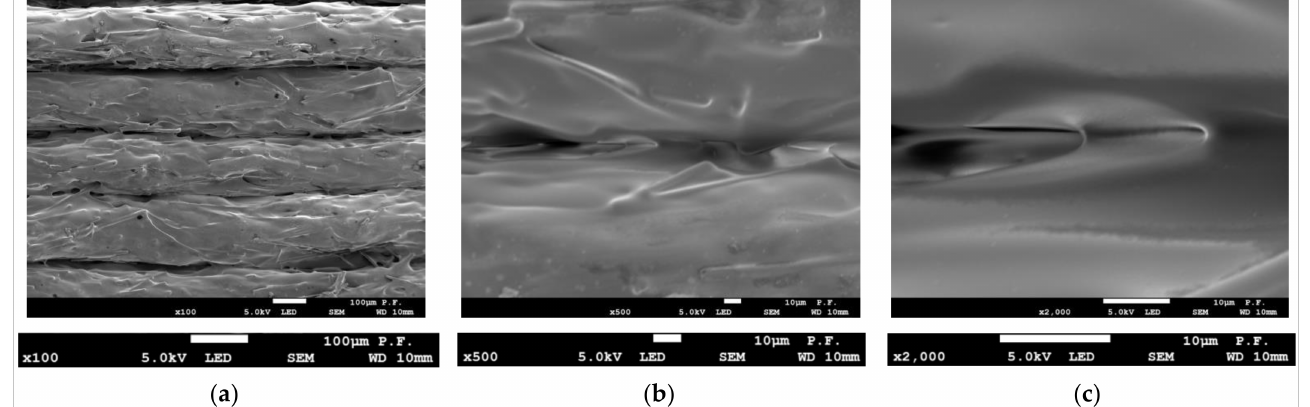
Figure 17. Side views of a 1.8 mm thick PLA-CF specimen before failure, ( a ) × 100 magnification, ( b ) contact zone between two filaments, × 500 magnification, ( c ) abnormalities at the bonding zone of two filaments, × 2000 magnification.